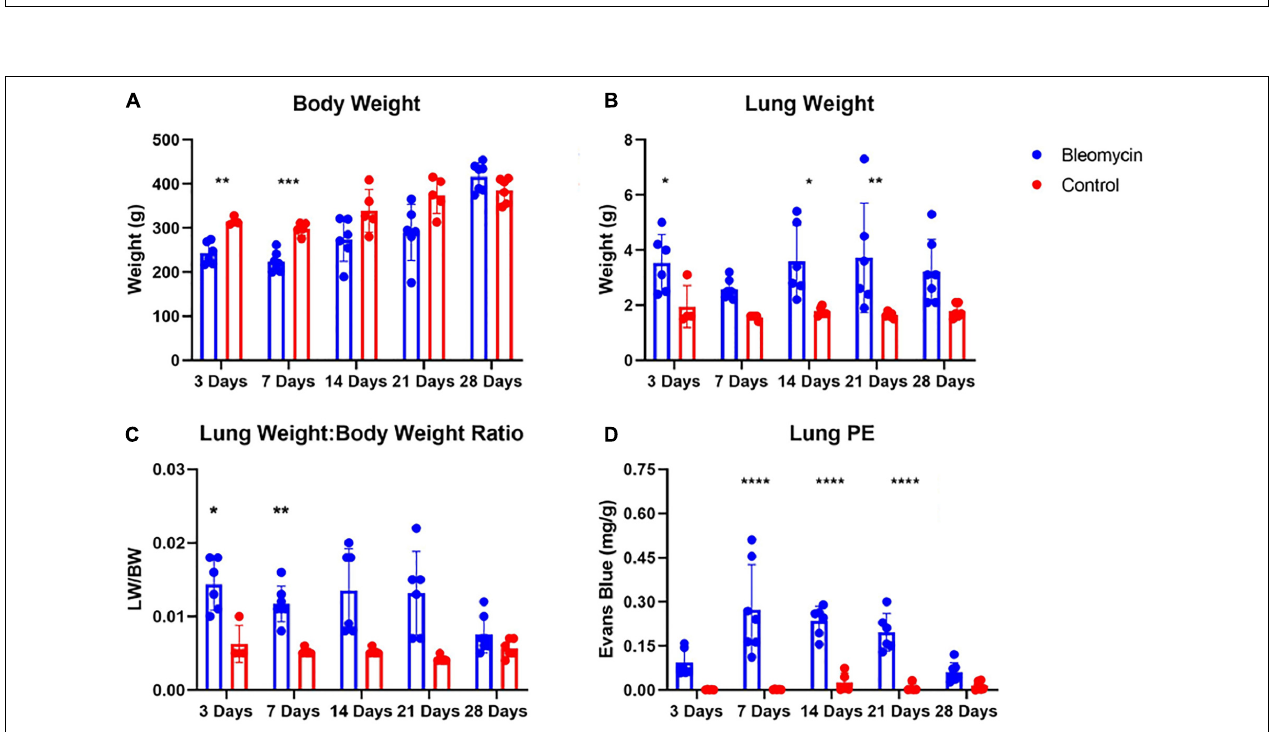
FIGURE 1 | Bleo instillation induces plasma extravasation (PEx) visualized by the tissue content of Evans Blue. PEx begins to occur around day 3 (B) and peaks around day 7 (C) . PEx subsequently plateaus at day 14 (D) and begins to resolve at day 21 (E) with resolution seen at day 28 (F) . Day 7 control is shown in panel (A) .